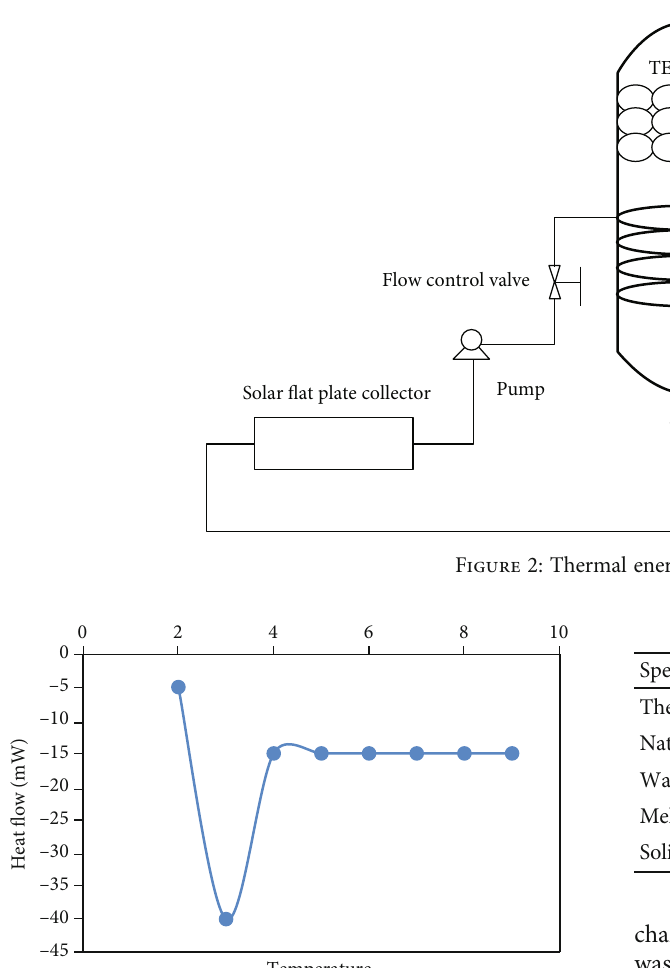
Figure 3: DSC curve.